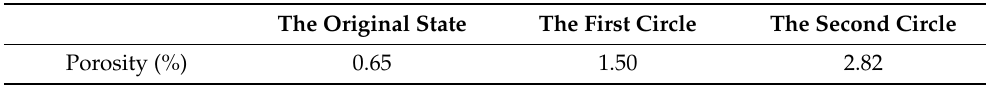
Table 10. Calculation results of overall porosity of concrete